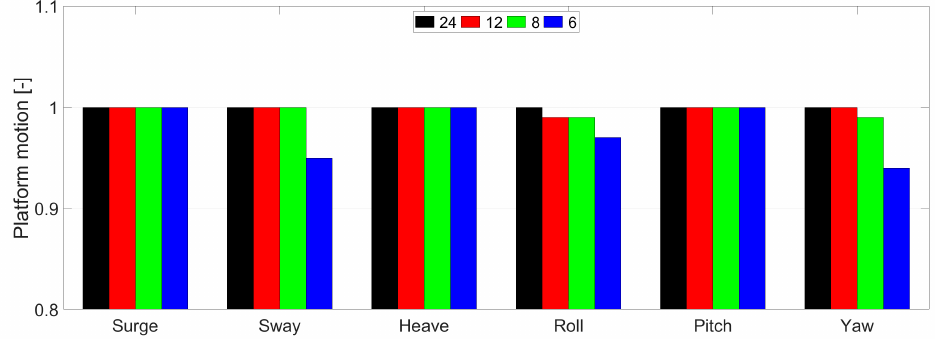
Figure 16. Maximum values of the fairlead and anchor tensions according to the interval angles.